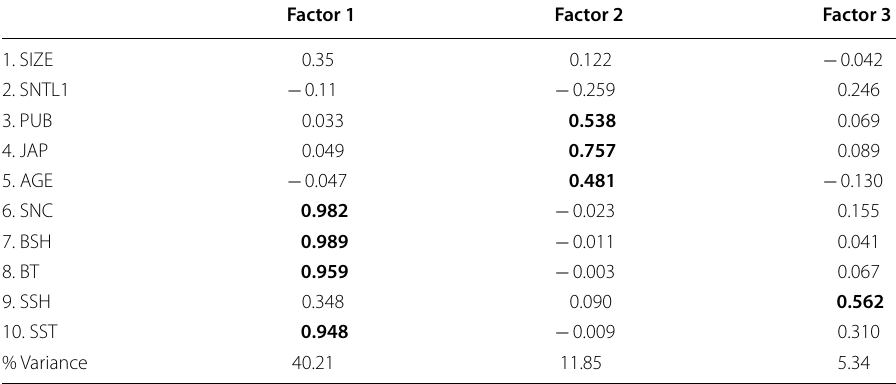
Significant variables with loading greater than 0.45 are depicted in